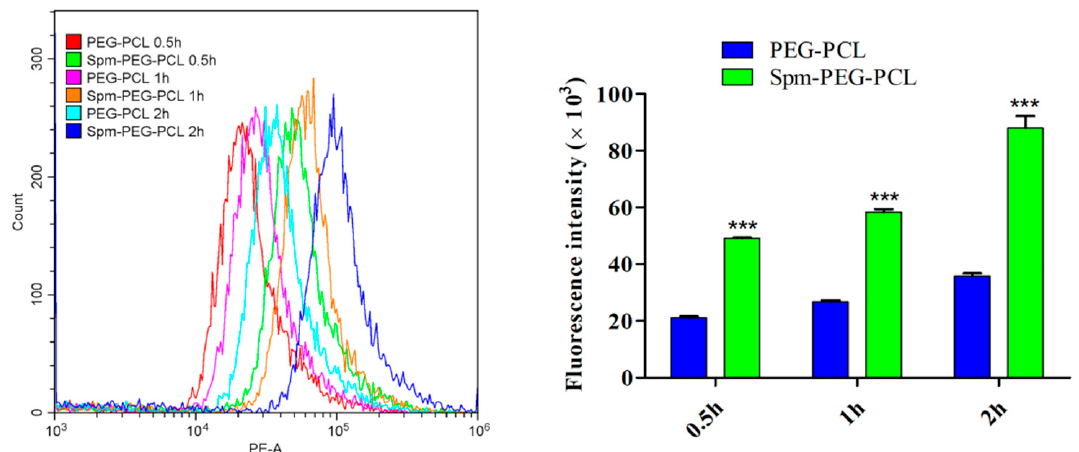
Figure 7. The cellular uptake of PEG-PCL/DOX and Spm-PEG-PCL/DOX micelles in A549 cells analyzed by flow cytometry ( n = 3), *** p < 0.001 compared to PEG-PCL micelles. Table 4. Flow cytometry data for the efficiency of micelle uptake (mean ± standard deviation, n = 3).